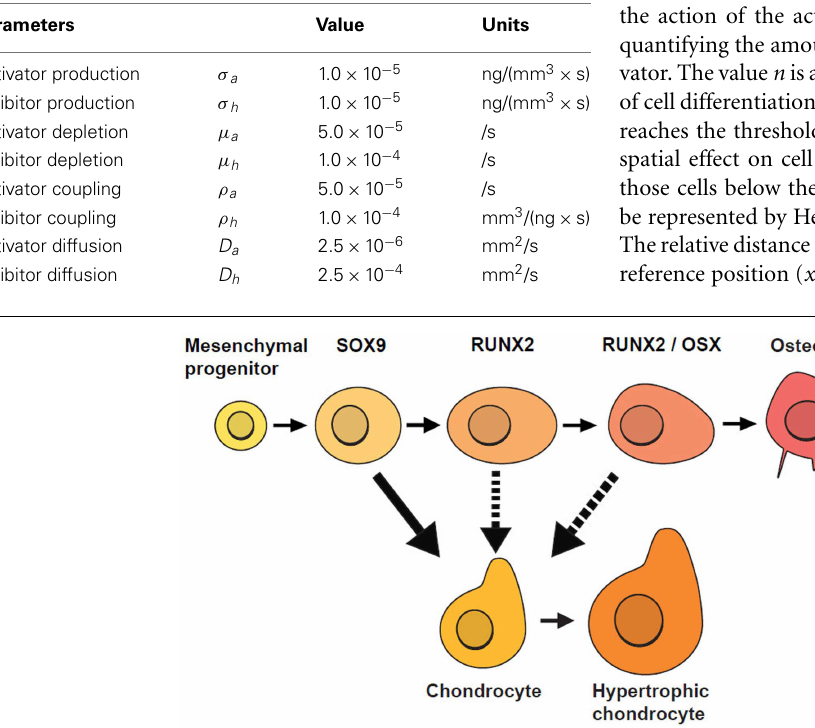
Table 1 | Model parameters in reaction–diffusion model of activator and inhibitor .